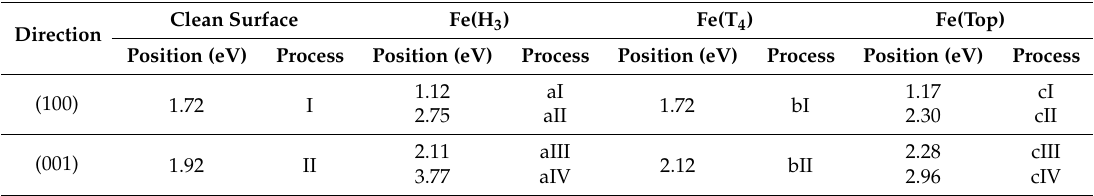
Figure 7. The calculated optical absorption spectra of the pristine and iron-adsorbed ZnO (0001) surfaces along the ( a ) (100) and ( b ) (001) directions. Vertical dash lines represent the energy range of visible light spectrum (i.e., 1.64–3.10 eV correspond to 760–400 nm). Table 3. The position of adsorption peaks of the iron-adsorbed ZnO (0001) surface along the (100) and (001) directions and the corresponding transition process.